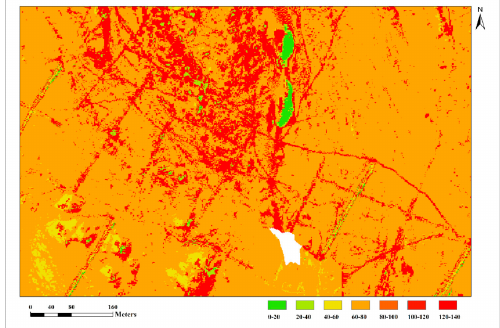
Figure 14. Cu content distribution map in local